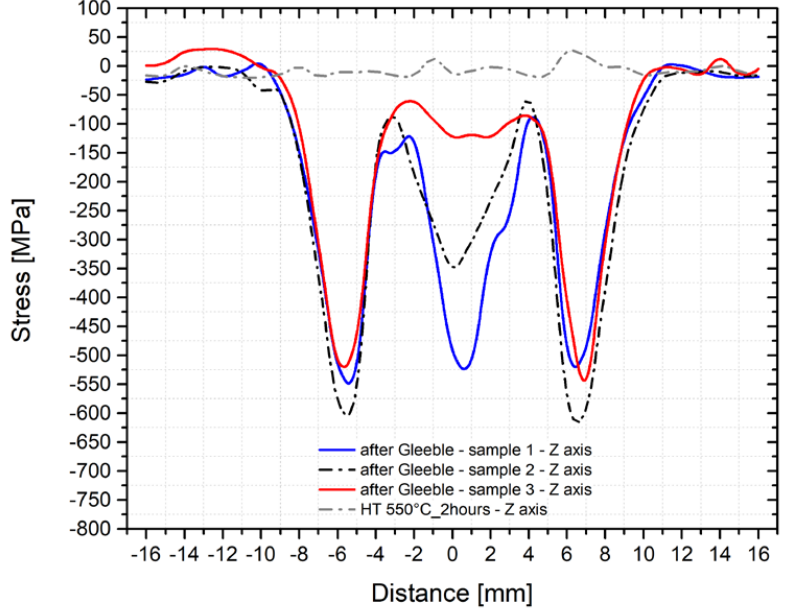
Figure 14. Course of the transverse residual stresses along the Z-axis after the application of the temperature cycle (three samples annealed at a temperature of 550 °C for 2 h).